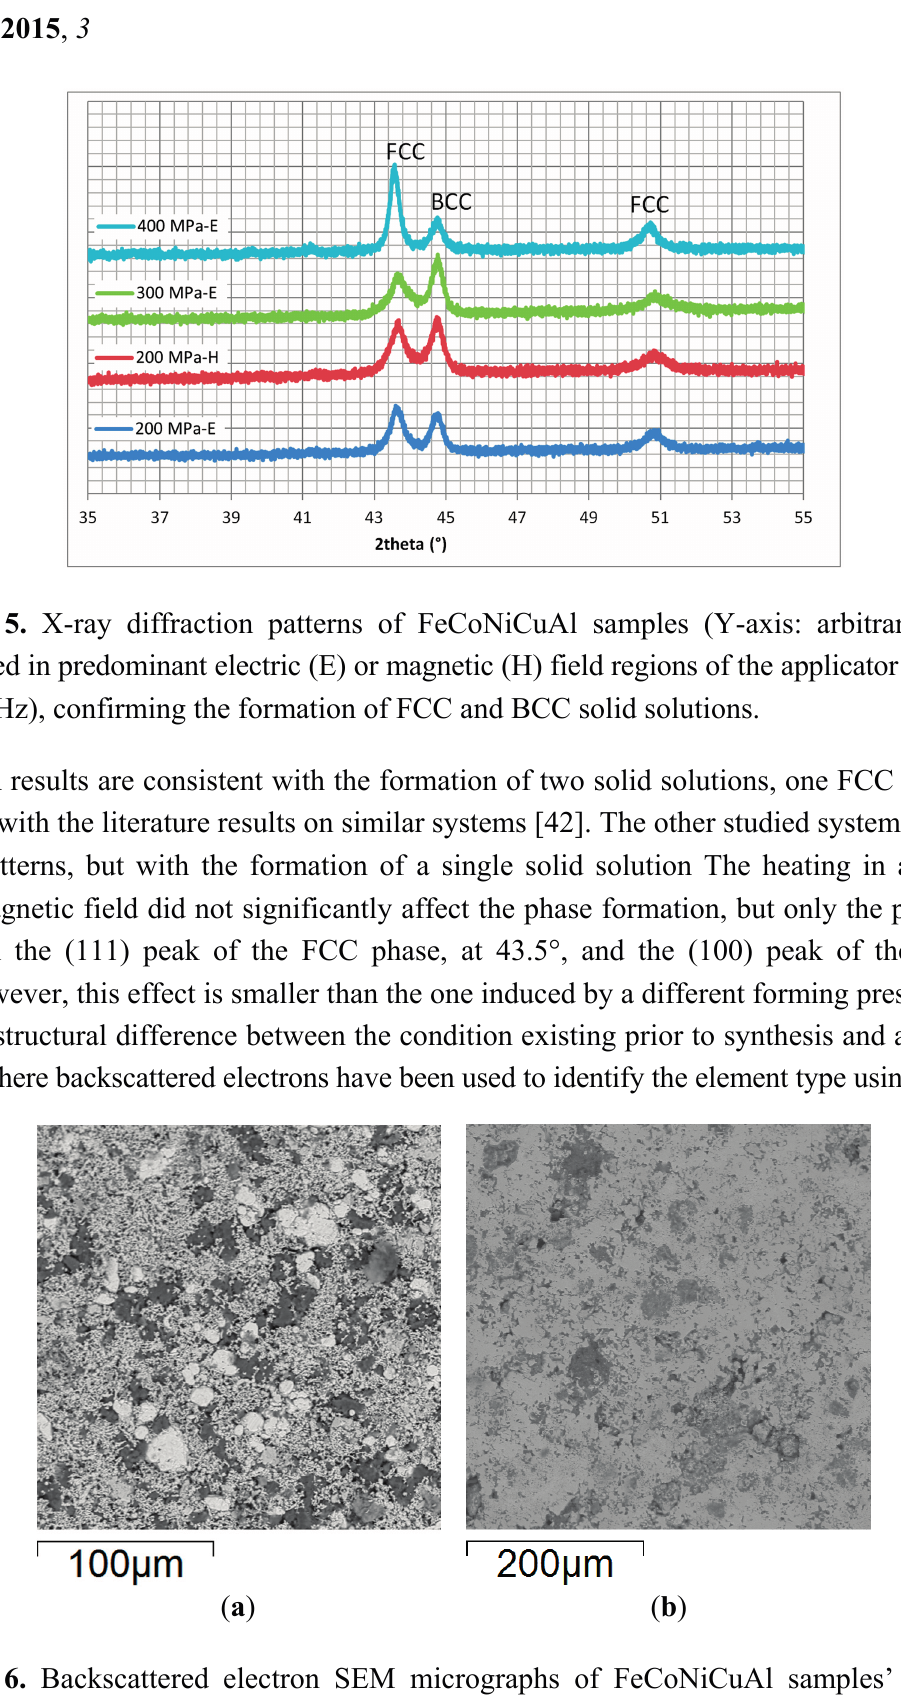
Figure 6. Backscattered electron SEM micrographs of FeCoNiCuAl samples’ surface: ( a ) after uniaxial pressing, 300 MPa; and ( b ) after microwave heating at 240 W, 5800 MHz, in regions of the predominant electric field of the applicator (forming pressure = 300